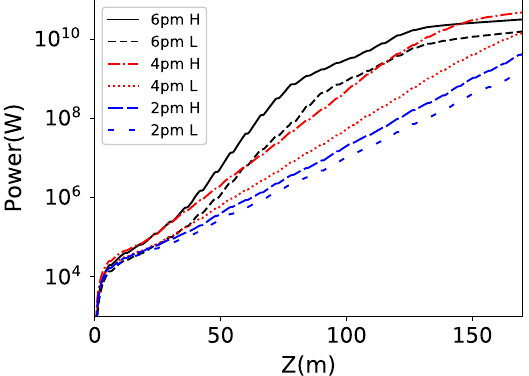
FIG. 9. Simulated power growth for cases of helical (H) and linear (L) polarization of sub-10-pm radiation wavelengths. The simulations were performed for an electron beam of either 30 GeV (black lines) or 40 GeV (red and blue lines) passing through a helical or planar Delta undulator FEL